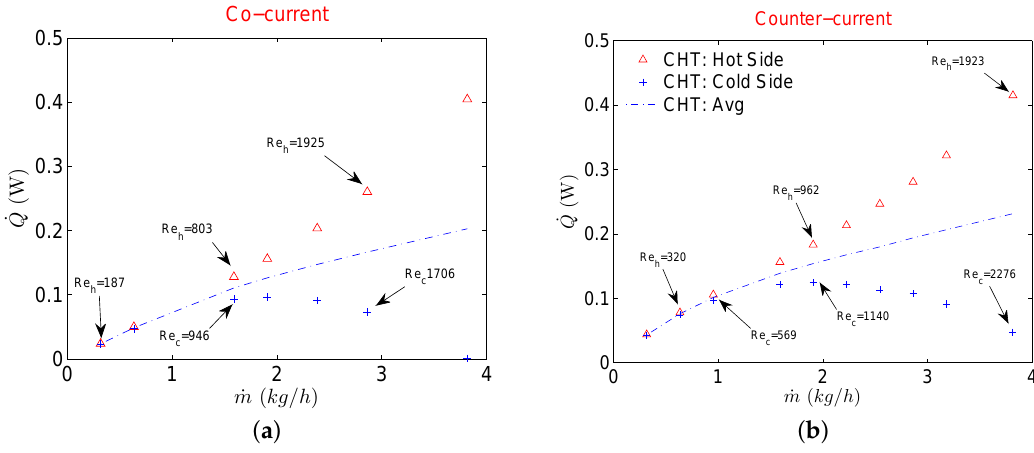
Figure 4. Heat transfer rate for CHT analysis when flow configuration is cocurrent ( a ), and counterflow ( b